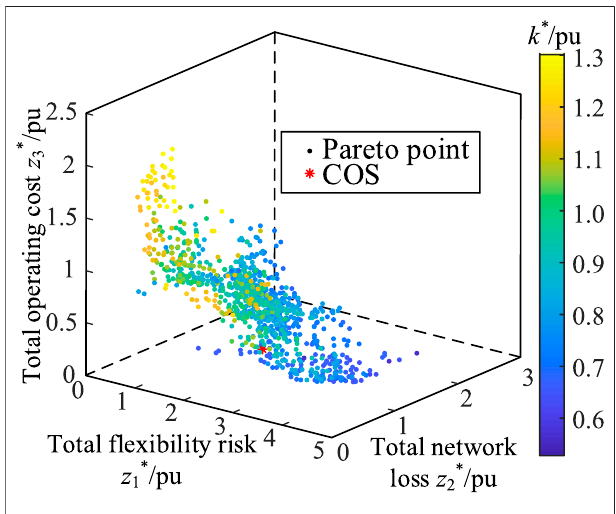
FIGURE 2 | Pareto frontier obtained by the grid-based ε -constraint method.